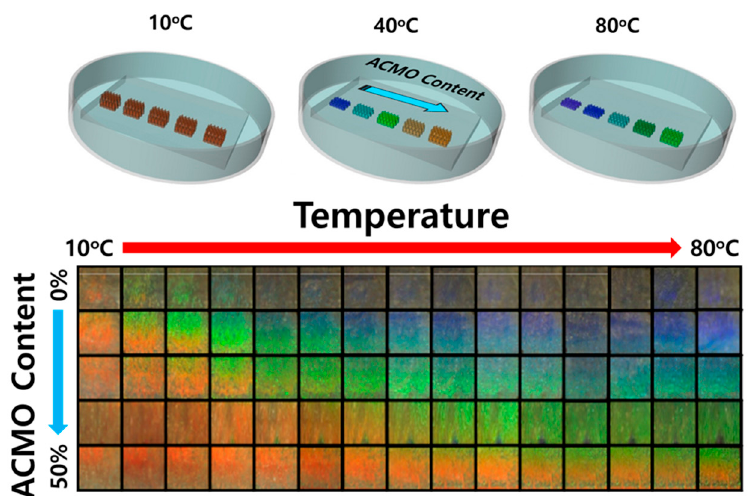
Figure 4. The temperature-driven color changes of five thermochromic photonic gels whose ACMO contents were 0, 15, 25, 35, and 50 mol %, respectively. Five photonic gels were templated by the same opal arrays on a single substrate. The time interval for each temperature was 30 min. As the ACMO content increased in the gel, the reflective colors tended to red-shift at a given temperature due to the more swollen state of the gel.